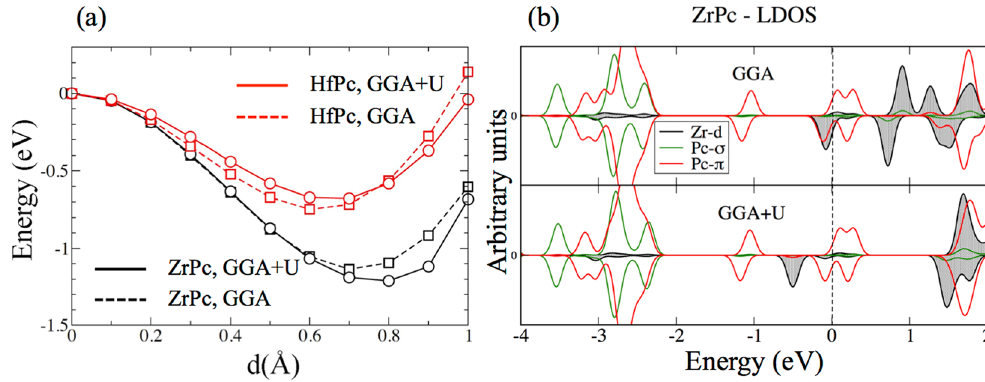
Figure 5. ( a ) Comparison between the energy barriers relative to the transition between the up - and down - configurations for ZrPc (black lines) and HfPc (red lines) molecules, calculated with the same method used in Fig. 2(b), where continuous (dashed) lines - circle (square) symbols refer to the GGA + U (GGA) calculations. d is the distance between the Zr(Hf) ion and the Pc plane. ( b ) Comparison between the spin-resolved LDOS for an isolated ZrPc molecule for the GGA (upper panel) and GGA + U (lower panel)